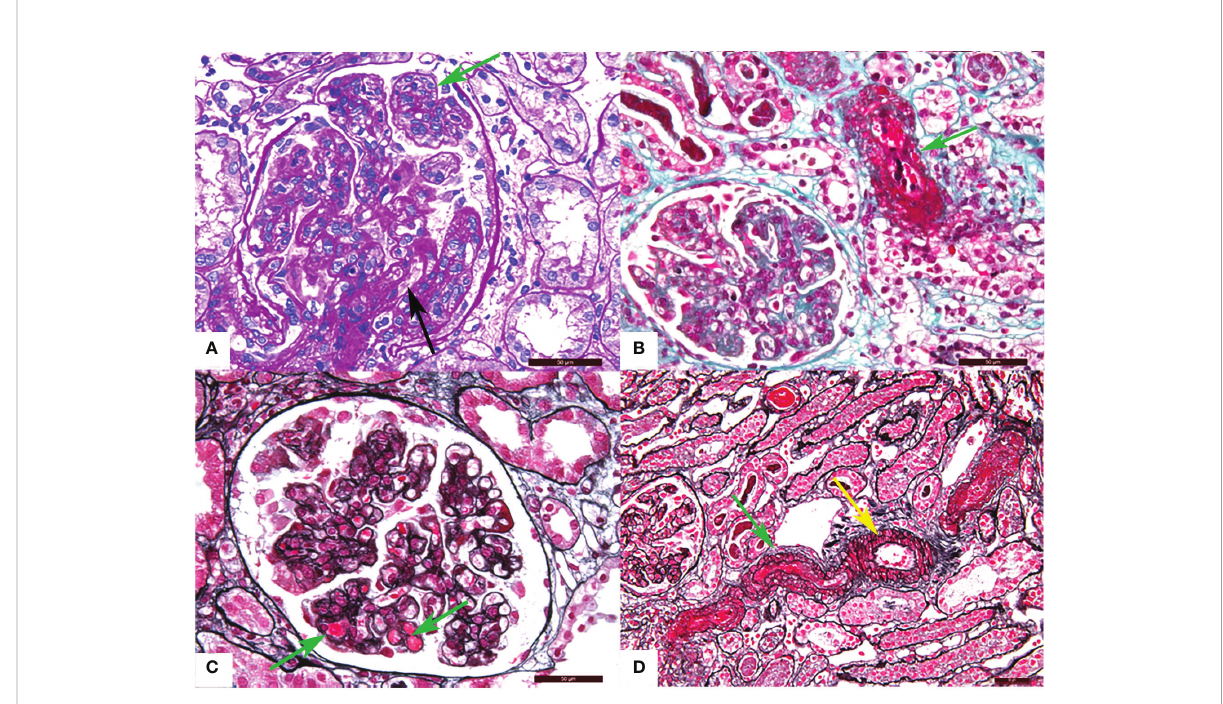
FIGURE 1 Representative light microscopy images of renal thrombotic microangiopathy (TMA). (A) Proliferation of glomerular mesangial cell and endothelial cell (green arrow), thickening of glomerular basement membrane and formation of the double track sign (black arrow) (PAS). (B) Fibrinous necrosis of the arteriole (green arrow) (Masson). (C) Microthrombosis in the glomerular capillary (green arrow) (PASM-Masson). (D) Arteriolar thrombosis (green arrow) and intimal myxoid oedema (yellow arrow) (PASM-Masson). PAS, periodic acid-schiff. PASM, periodic acid-silver methenamine. Scale bars represent 50 m